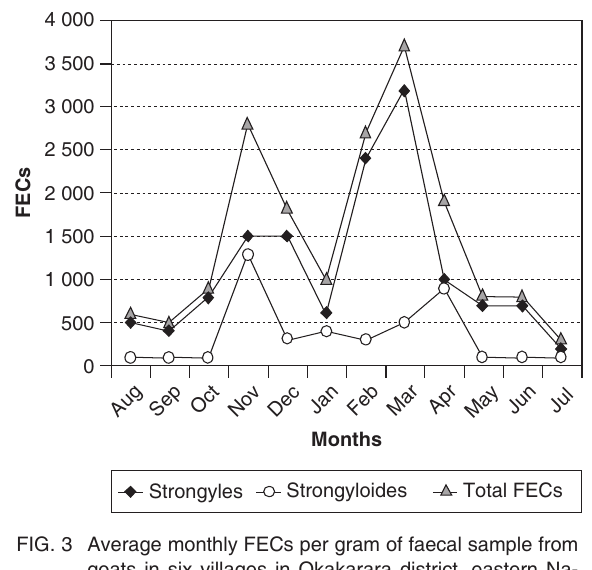
FIG. 1 Average seasonal FECs per gram of faecal sample from goats in six selected villages in Okakarara dis- trict, eastern Namibia (August 1999 to July 2000)